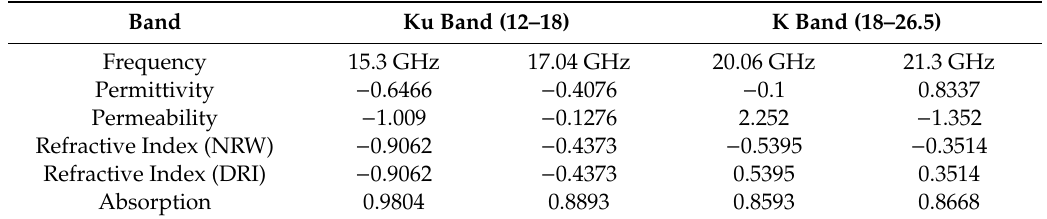
Table 2. Maximum absorptions with double negative (DNG) and single negative (SNG) values. Band Ku Band